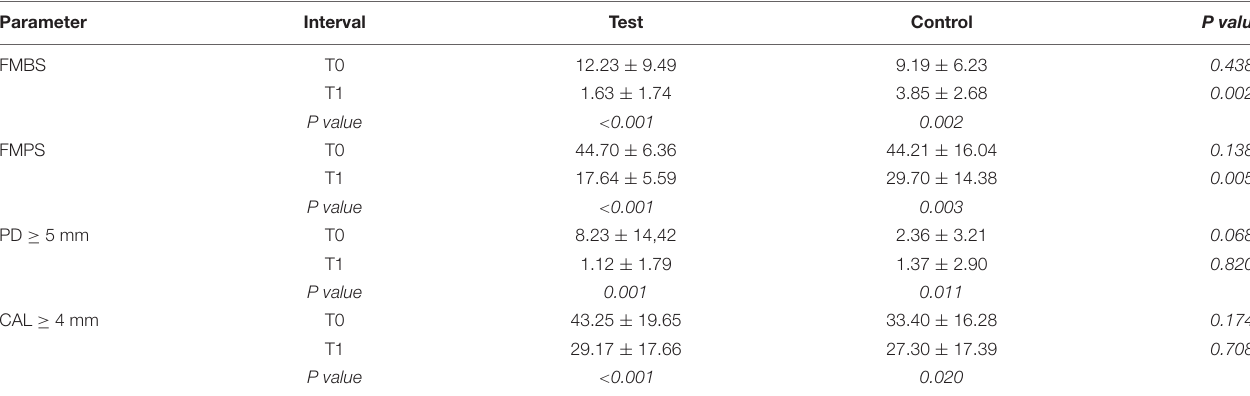
Frontiers in Physiology |